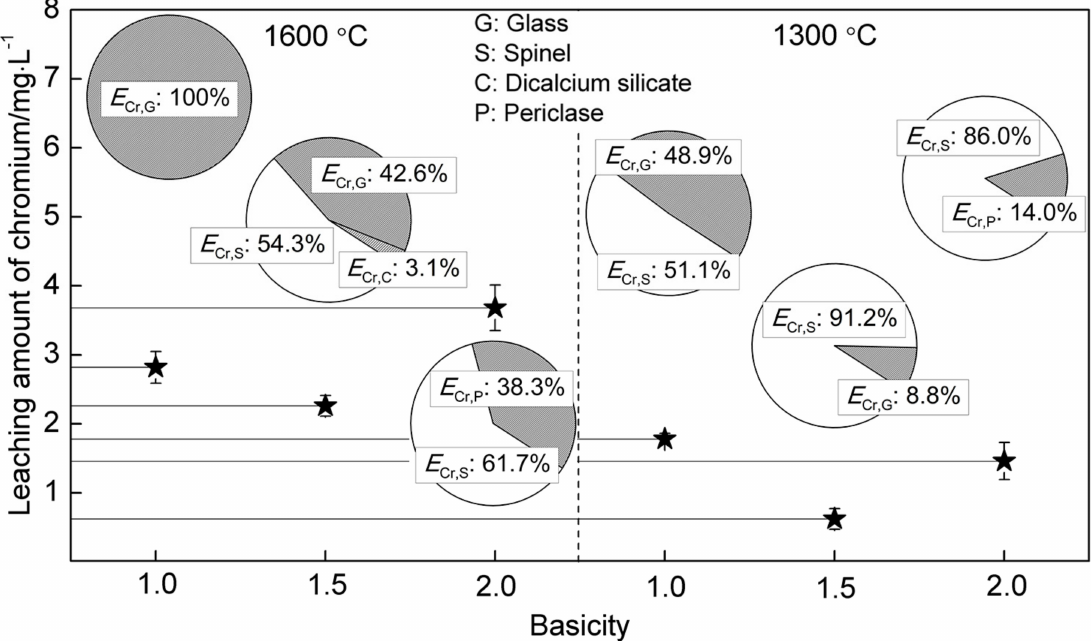
Figure 5. Distribution (pie chart) and leaching amount of chromium of S1, S2, and S3 quenched at 1600 and 1300 ◦